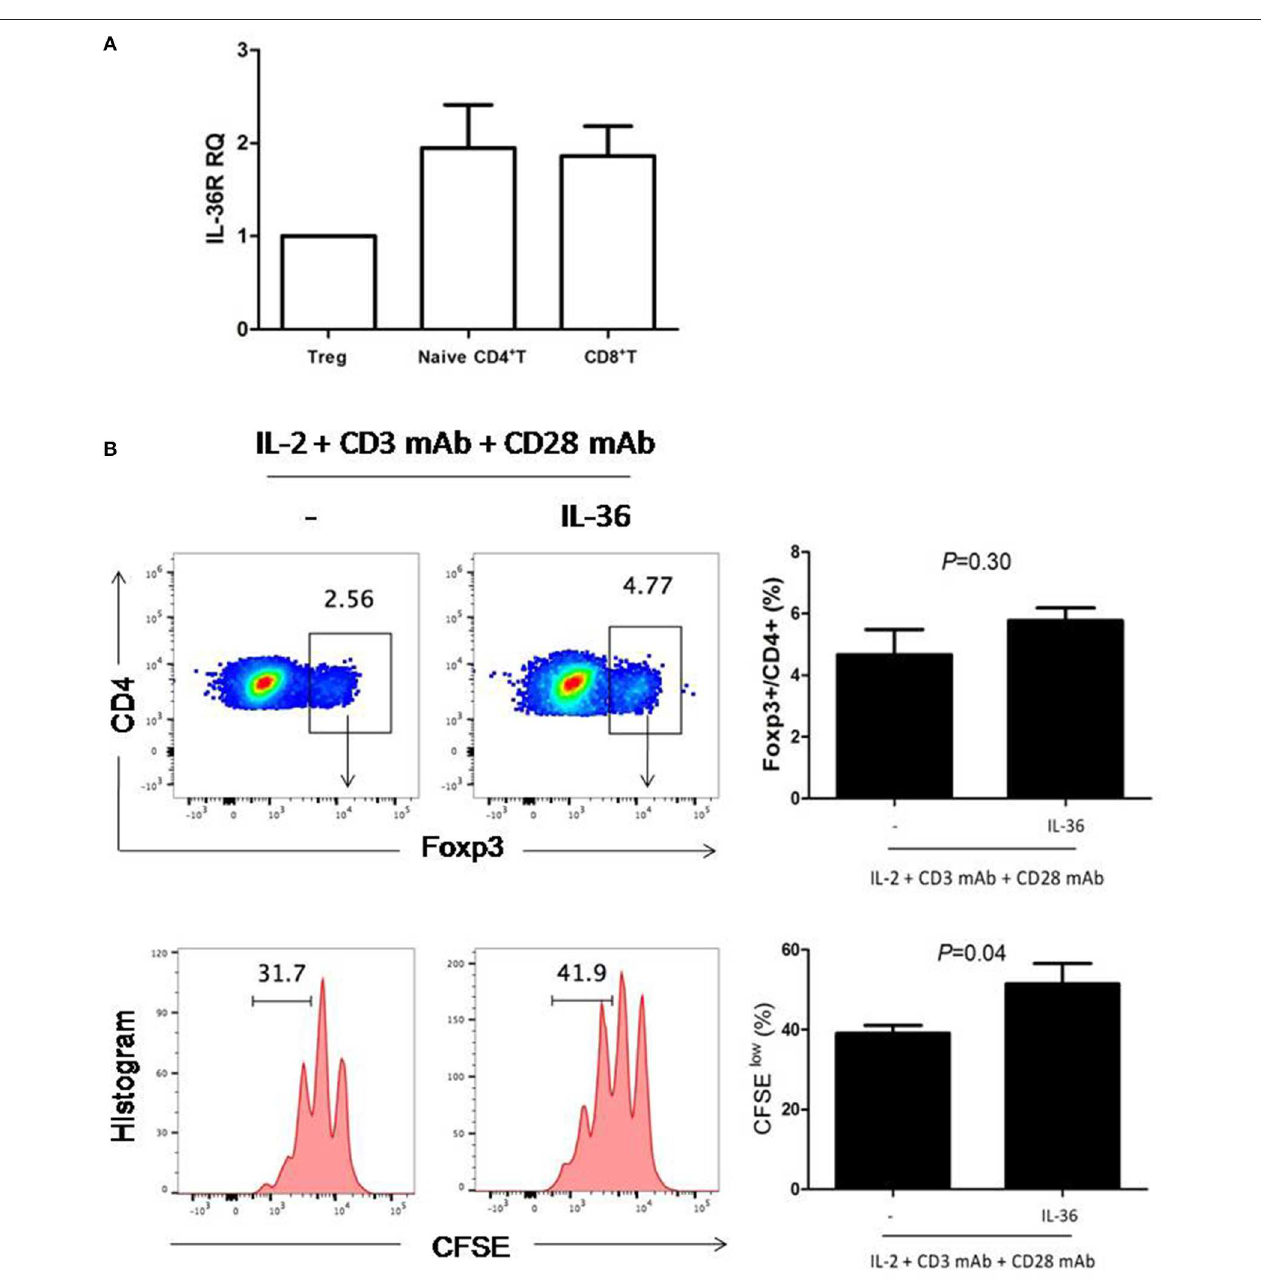
FIGURE 2 | IL-36R was expressed and functional in Treg cells. (A) , naïve CD4 + T cells (Th0 cells), naïve CD8 + T cell and Treg were purified by FACS. Total mRNA was isolated for analyses by quantitative RT-PCR. Results represented IL-36R mRNA expression levels relative to GAPDH . (B) , flow cytometric analysis of Treg cells proliferation responses induced by IL-36-stimulated splenic CD4 + T cells. Splenic CD4 + T cells were stimulated with anti-CD3 and anti-CD28 antibodies with or without IL36 for 72h. CFSE dilution was used to evaluate T cell proliferation responses 72h following co-culture. Flow cytometry plot is representative of four independent experiments. Results are mean ± SEM of three independent